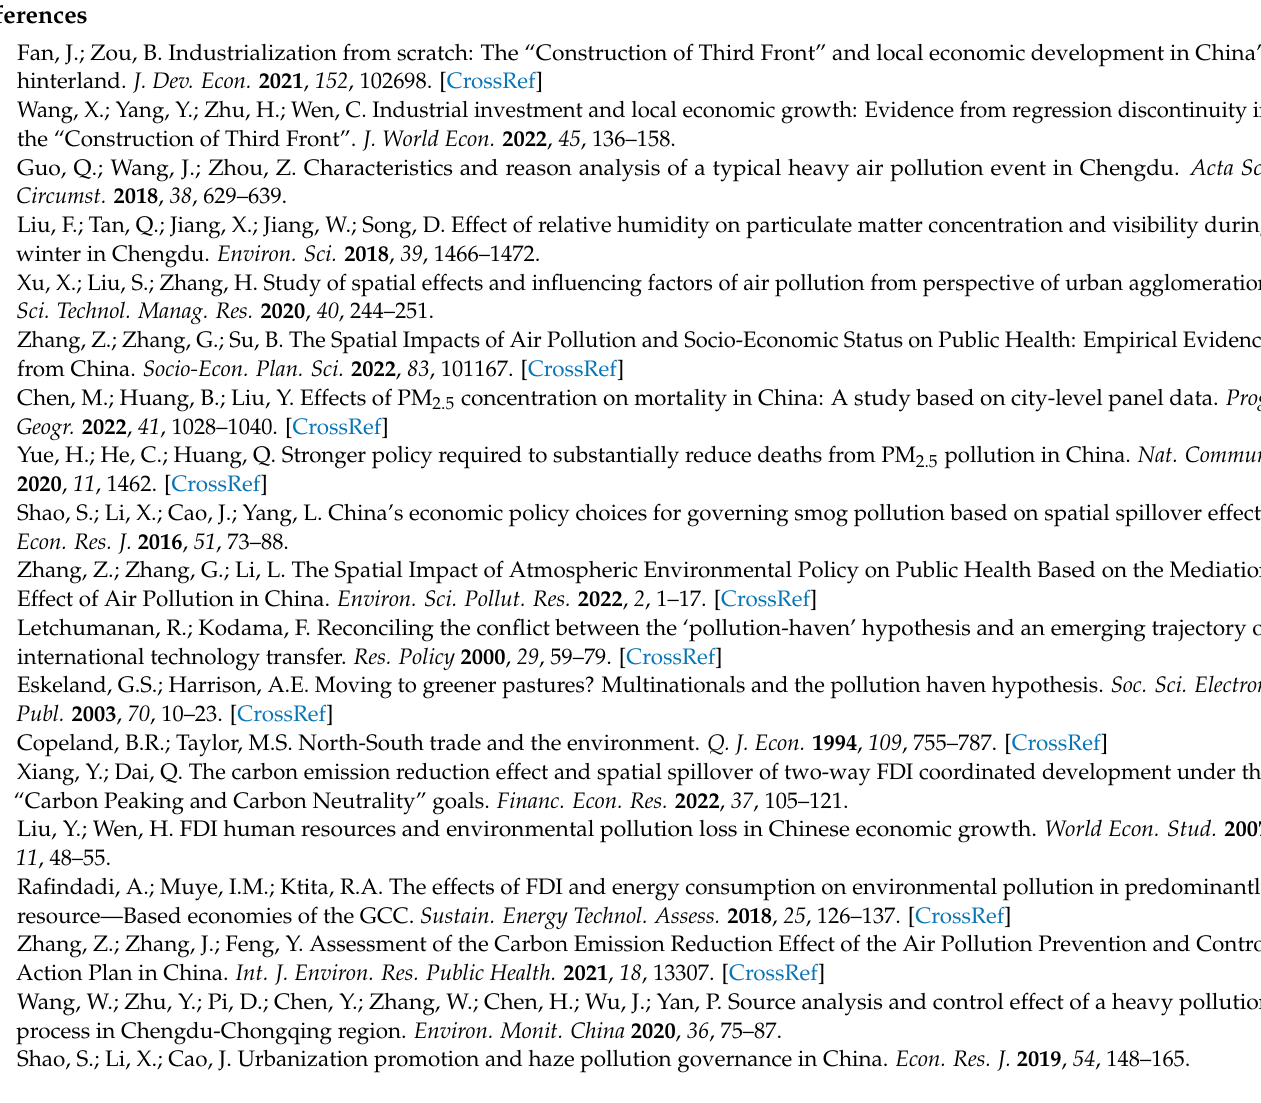
Figure A1. The scatter plot of PM 2.5 pollution in Sichuan–Chongqing urban agglomeration in the geographic distance weight matrix.